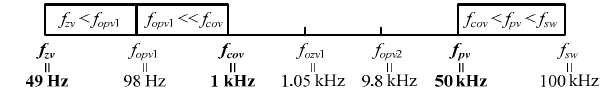
Figure 14. Frequency point setting of charge voltage loop.